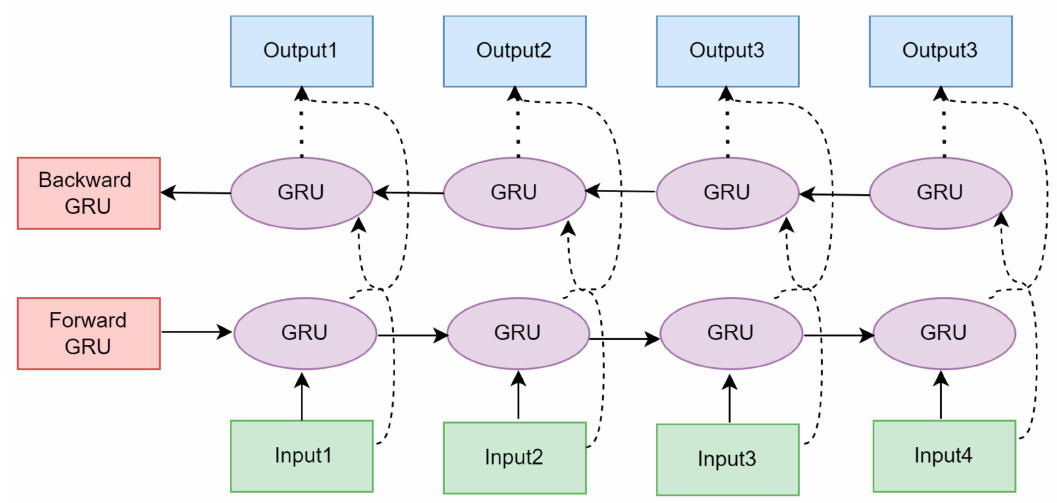
Figure 3. Bidirectional Gated Recurrent